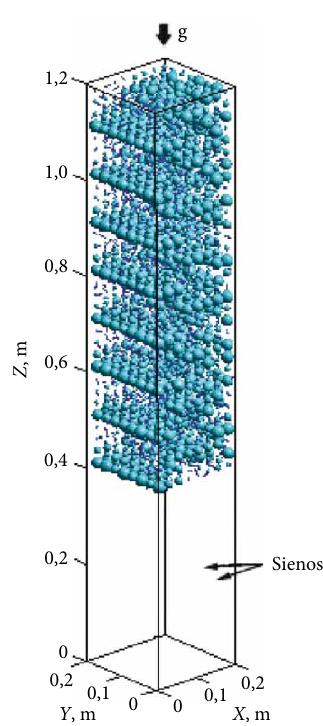
Fig. 3. Model for the tangent force of a contact (with no is limit displacement viscous component) where (cid:71) u of a microslip Fig. 4. Free fall of the polydispersed particle